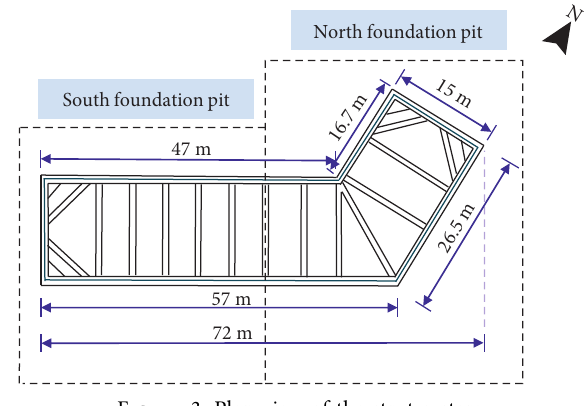
Figure 3: Plan view of the strut